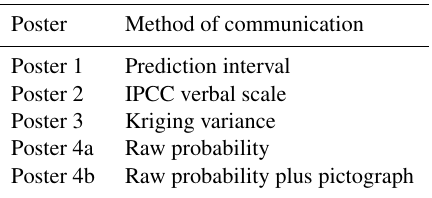
Table 1. The designated poster number for each method of commu- nicating uncertain